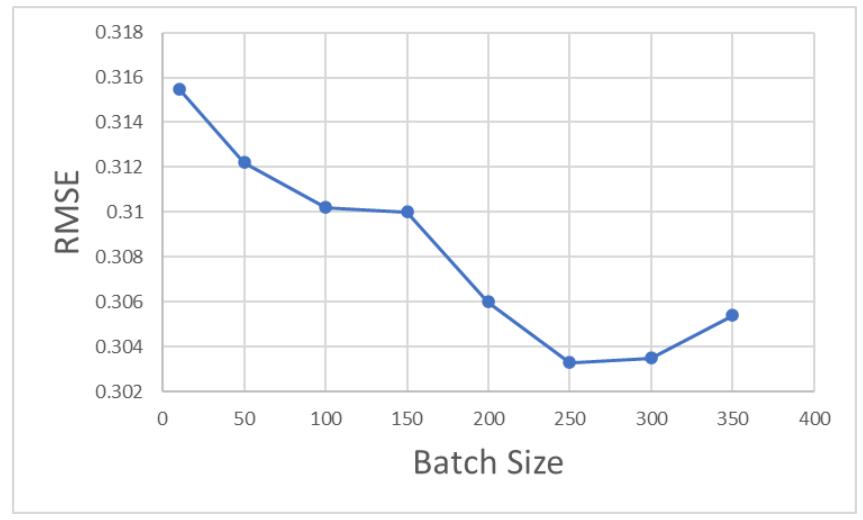
Figure 18. Effect of different batch sizes on model accuracy using frequency-domain data.